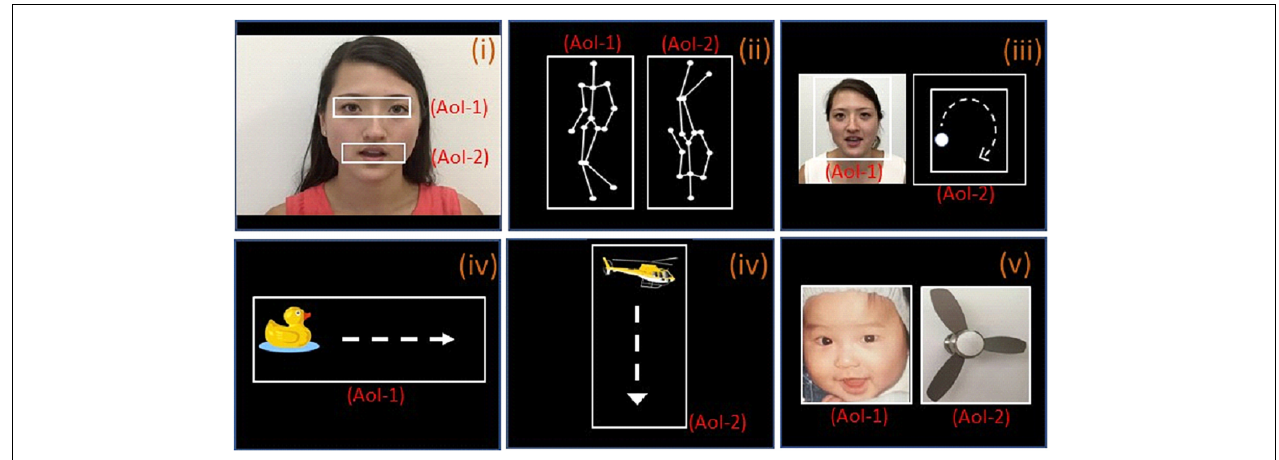
FIGURE 1 | The paradigms used for eye-tracking with area of interest (AOI). (i) Female face with moving mouth; AOI-1 and AOI-2 include the eye and mouth regions, respectively. (ii) Biological motion; AOI-1 and AOI-2 are point-light display figure of a person walking upright and in the other side, inverted images (upside down), respectively. (iii) People and geometry (same size); AOI-1 and AOI-2 are same-sized images of human face with moving mouth and geometry (moving white dot) respectively. (iv-1) , a clipart duck moving horizontally from the left side of the screen to the right side, the moving pathway is AOI-1, (iv-2) , a clipart helicopter moving vertically from the top of the screen to the bottom, moving pathways is the AOI-2; (v) , baby and object (same size); AOI-1 and AOI-2 are same-sized images of baby face and fan